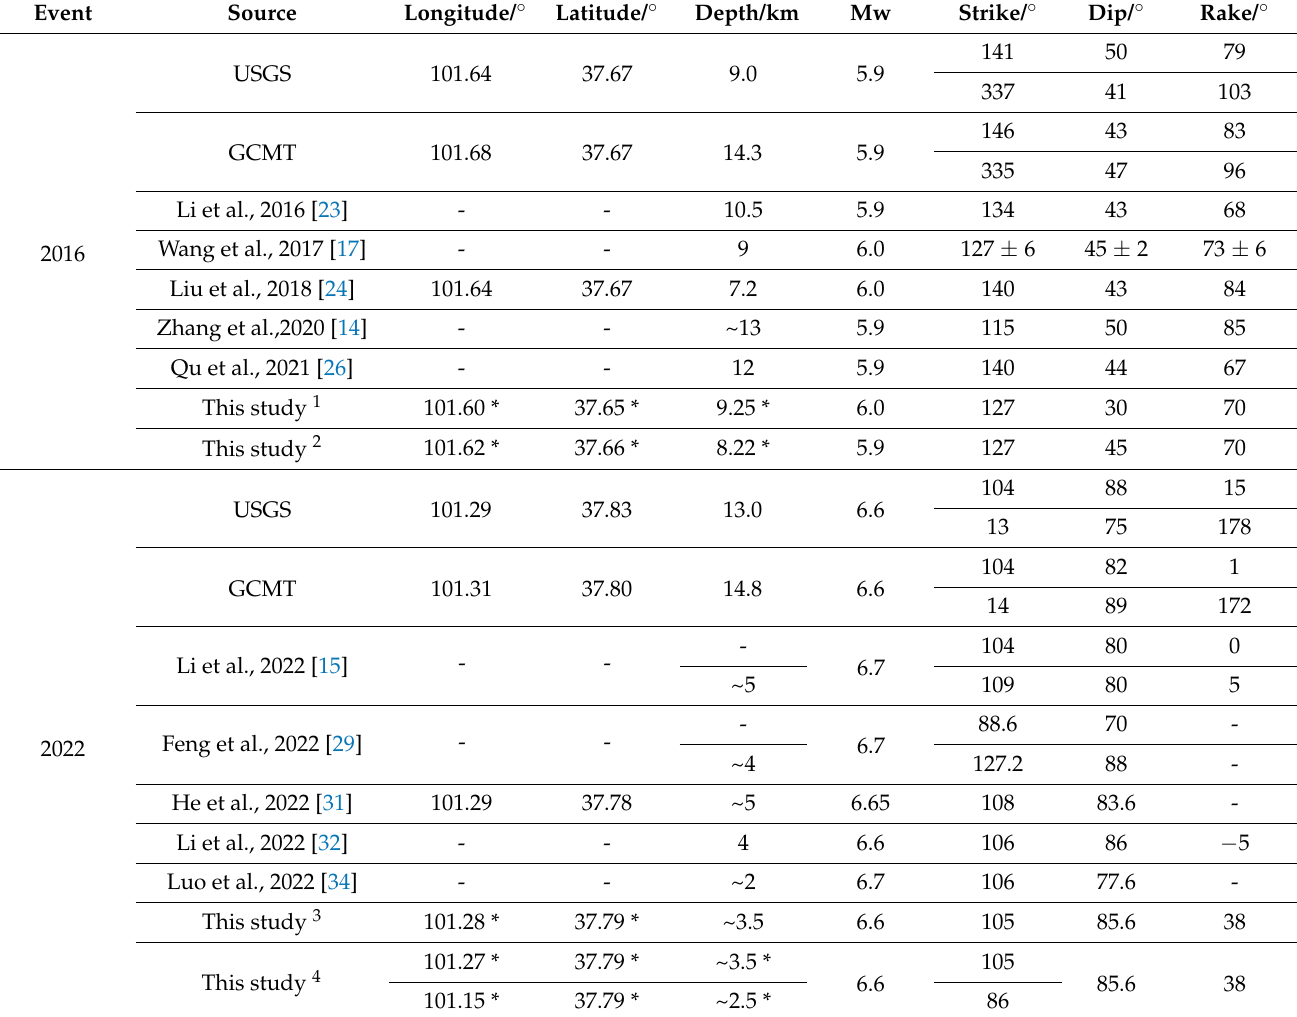
The blue beach balls are the GCMT focal mechanisms of earthquakes (Mw > 5.0) from 2012 to 2022. The light blue circles are small and moderate earthquakes (<Ms 6.0) between 2009 and 2020 from the China Earthquake Networks Center. Red dots show the historical earthquakes with Ms > 7.0. The dashed rectangles represent the footprint of the SAR data. Black rectangle outlines the extent shown in Figure 1b. The red rectangle in the inset map indicates the location of Figure 1a. The inset map shows the interseismic GNSS velocities from Wang and Shen [37]. Segments of the Qilian-Haiyuanfault sys- tem: S1: Tuolaishan, S2: Lenglongling, S3: Jinqianghe, S4: Maomaoshan, S5: Laohushan, S6: ruptured segments during the 1920 Haiyuan earthquake. ( b ) Faults and earthquakes in the Menyuan area. The pink and gray points represent the relocated aftershocks of the 2022 event and the 2016 event [18,28]. The red and blue beach balls are the focal mechanisms of the two Menyuan earthquakes from the USGS and the GCMT, respectively. The blue lines show the profile location of the regional tectonic model. MYDMYF: the Minyue-Damaying fault; NLLLF: the northern Lenglongling fault; TLSF: the Tuolaishan fault; LLLF: the Lenglongling fault. ( c – e ) Aftershock profiles along aa’, bb’, and cc’ (width = 20km), color-coded by time after the mainshock, with profile locations shown in Figure 1b. The profile aa’ and bb’ are aftershocks of the 2022 event and the fault (Distance = 0) means LLLF, while the profile cc’ contains aftershocks of the 2016 event and the fault (Distance = 0) means NLLLF. Table 1. Focal mechanism parameters of the 2016 and 2022 Menyuan